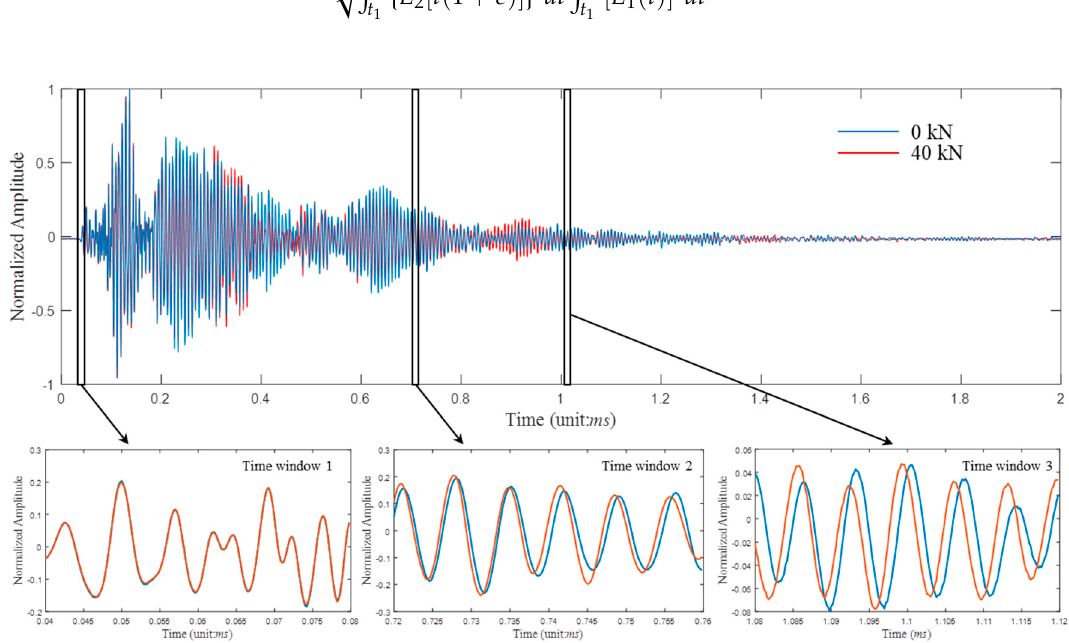
Figure 4. The average full coda waveforms collected from the C30-1 sample by the R1 receiver at 0 and 40 kN.